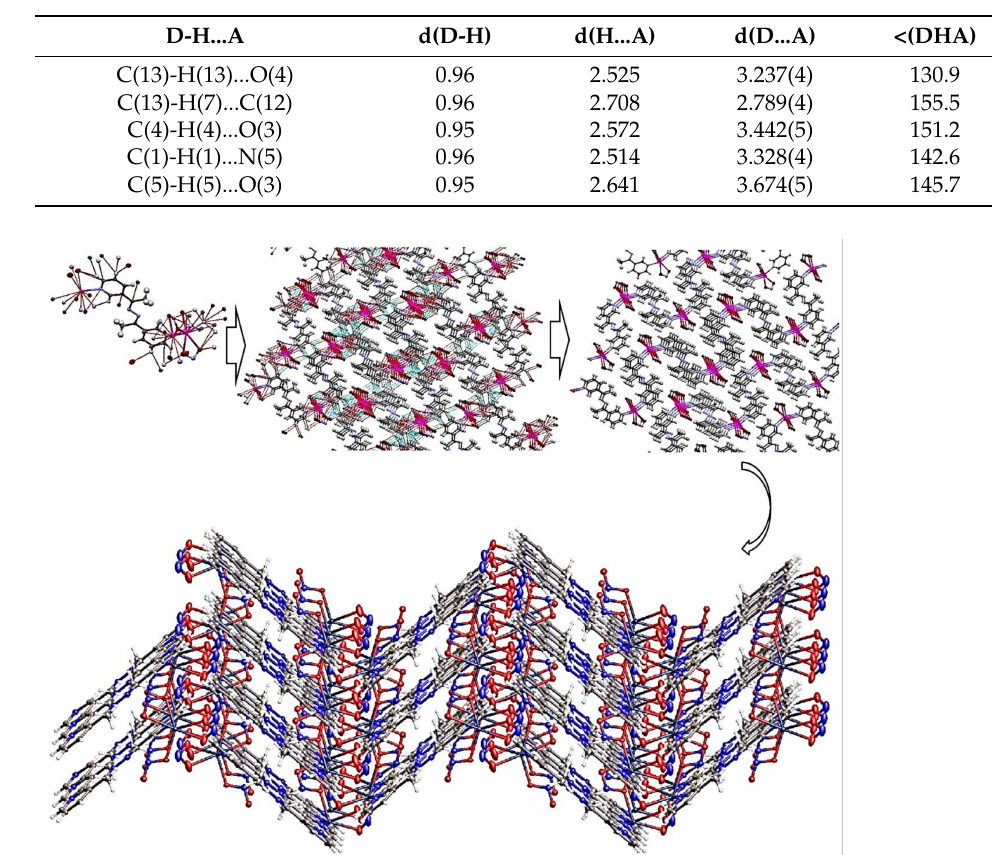
Figure 6. From di nuclear complexes to 3D